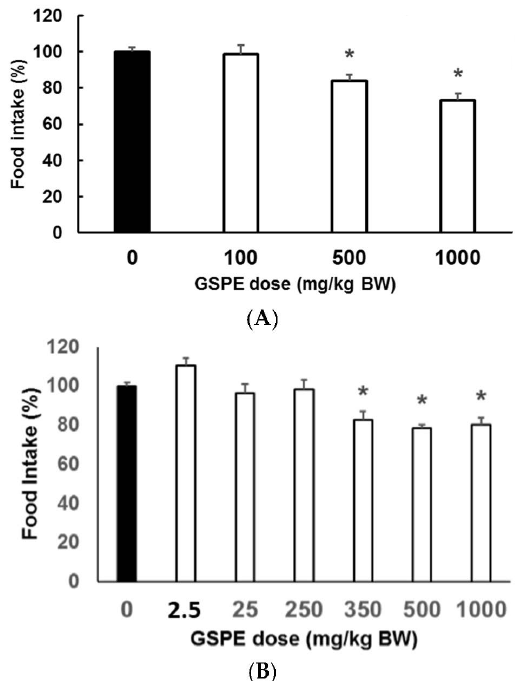
Figure 2. Range of effective doses at which grape seed proanthocyanidin extract (GSPE) inhibits food intake. Wistar rats received one of the various GSPE doses ( white columns). Control animals are indicated as black columns. Food intake was measured twelve hours after the initiation of food intake period. ( A ) rats on a highly palatable diet; and ( B ) rats fed with standard chow. Results are shown as % vs. control group. n = 6 per group; * p < 0.05 vs. control group by Dunett’s test after